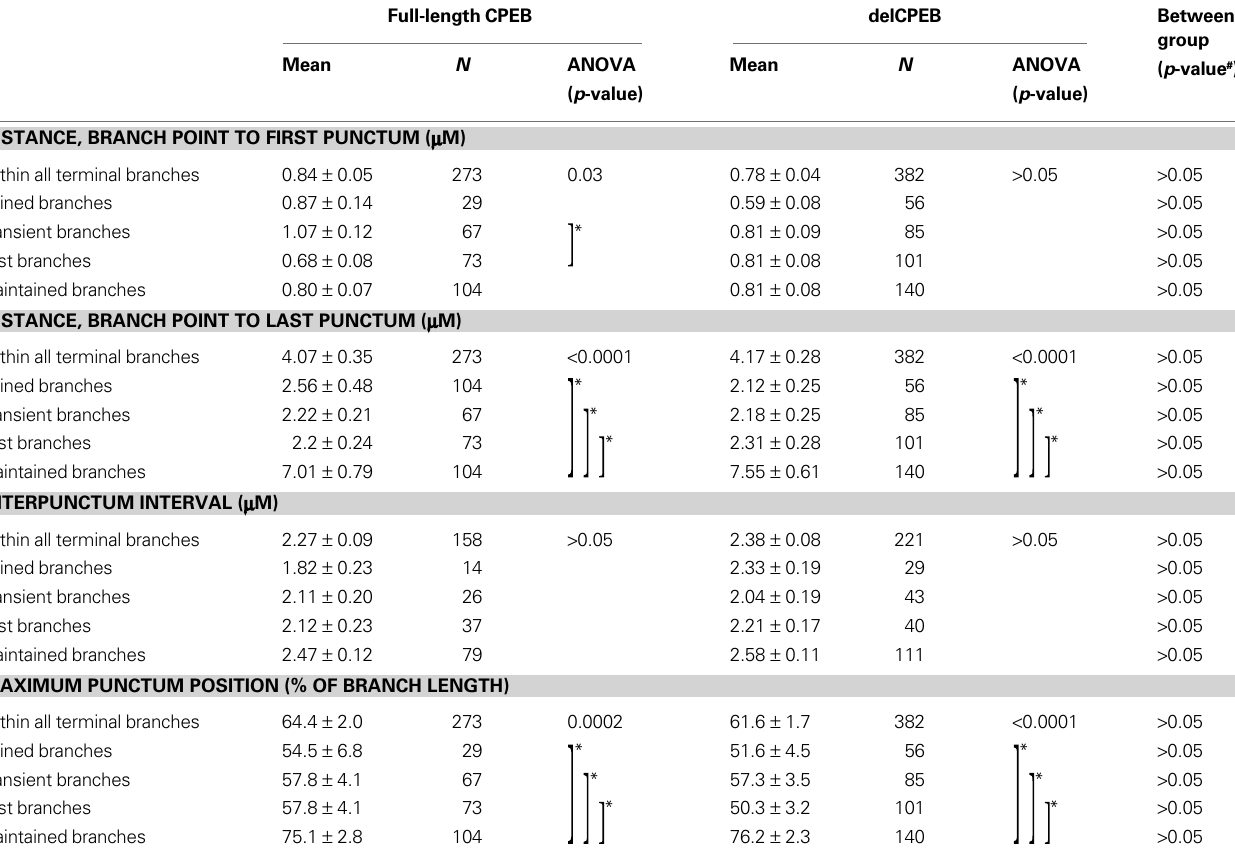
Table 1 | Puncta positions within the terminal branches. Full-length CPEB delCPEB Between ANOVA Mean ANOVA